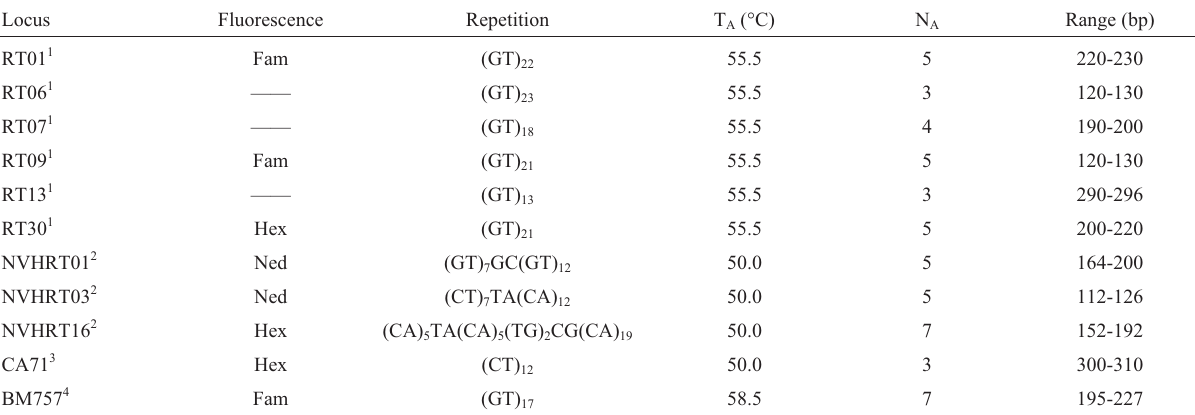
Table 1 - Summary of the 11 microsatellite loci included in the characterization of 13 female pampas deer ( Ozotoceros bezoarticus leucogaster ) from the Brazilian Pantanal using heterologous primers.